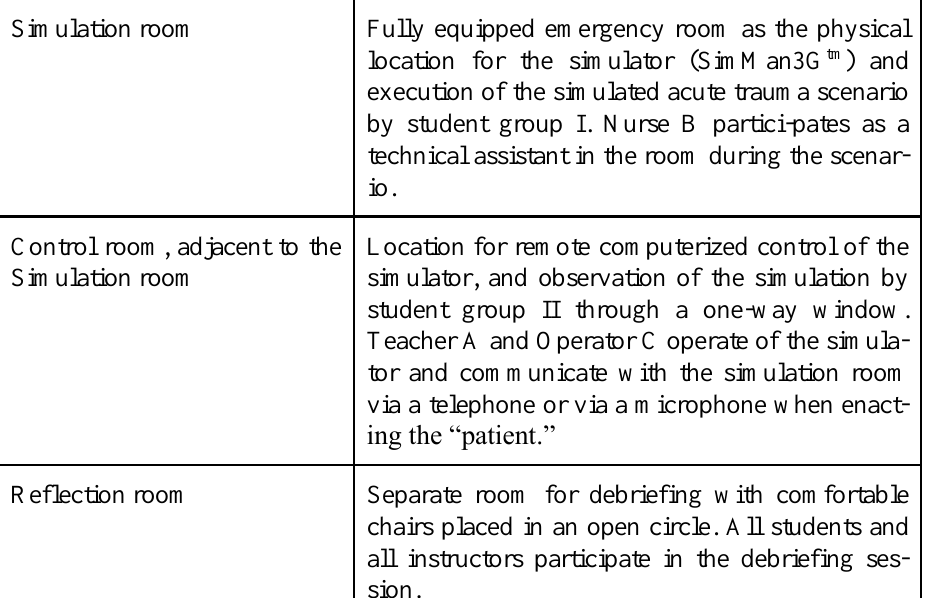
Table 1. Observed locations for emerging knowings and learning in simulation. Simulation